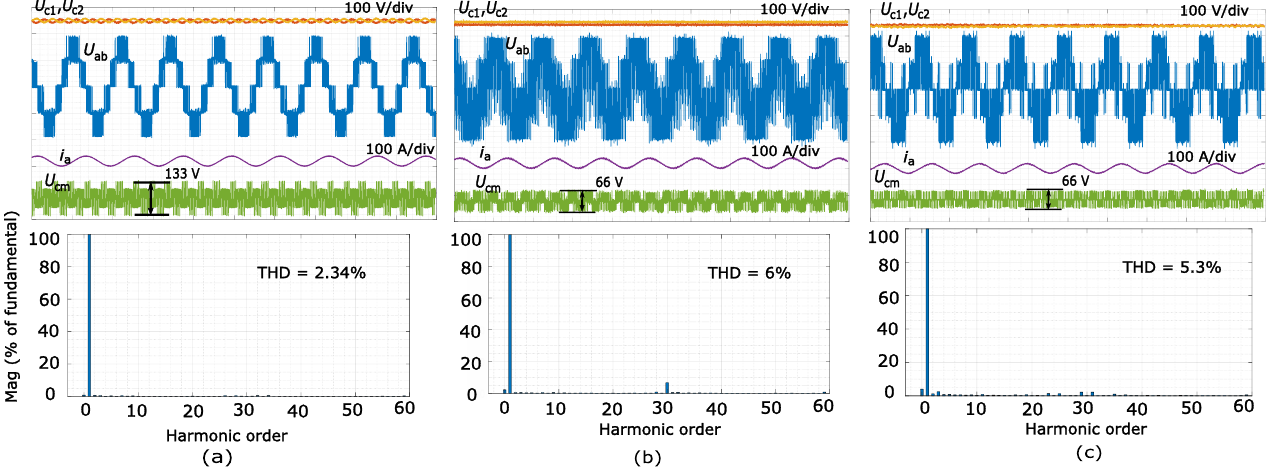
Figure 17. Measured line-to-line voltage, DC-link capacitor voltages, output current i a , common- mode voltage U cm , and harmonic content for Case I; ( a ) conventional CBPWM, ( b ) RCMV-CBPWM where only phase a is reversed, ( c ) proposed